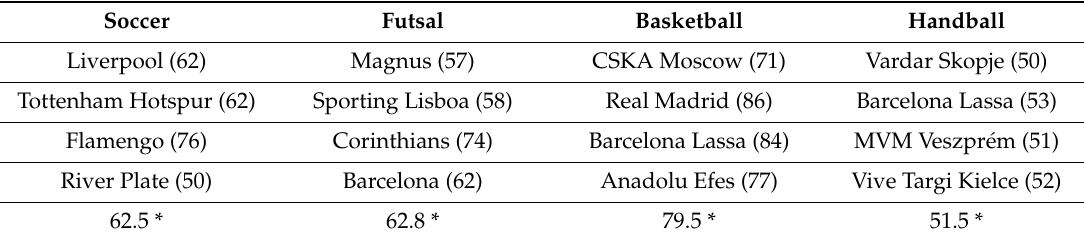
Table 3. Number of matches of the season 2018–2019 for all team sports evaluated (men, elite teams).